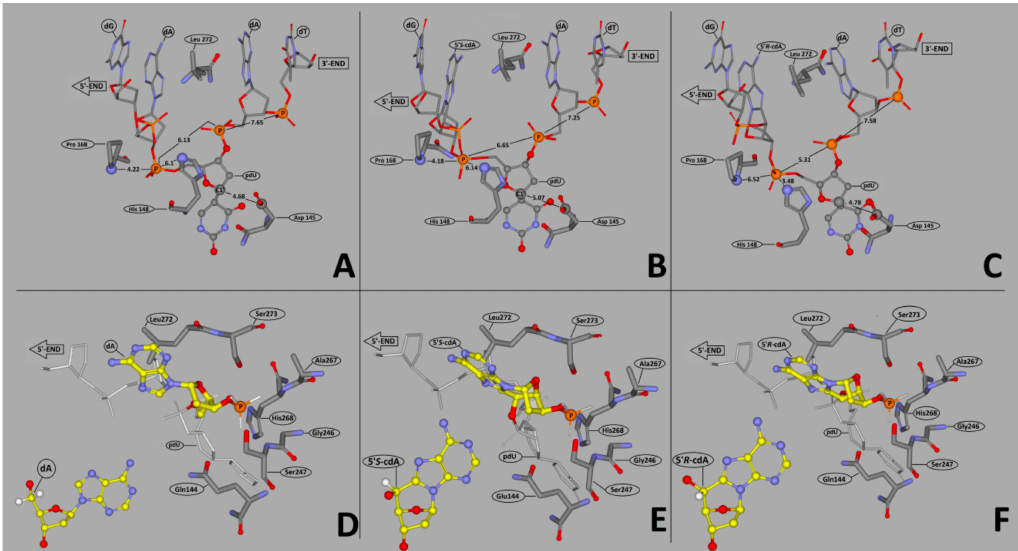
Figure 6. Graphical representation of the distances in Å between the diagnostic amino acids His148 / Pro168 and the phosphate group (5 (cid:48) -cdA PO pdU-3 (cid:48) ), as well as pdU C1’ and His148 endocyclic nitrogen atom: ( A ) ds- Cont.pdU, ( B ) ds- ScdA( + 1) and ( C ) ds- RcdA( + 1). ( D ) The reference ds -oligonucleotide contains 2 (cid:48) -deoxyasdenosine ( ds- Cont.pdU), ( E ) the oligonucleotide contains (5 (cid:48) S )-5 (cid:48) ,8-cyclo-2 (cid:48) -deoxyadenosine ( ds- ScdA( − 1)), ( F ) the oligonucleotide contains (5 (cid:48) R )-5 (cid:48) ,8-cyclo-2 (cid:48) -deoxyadenosine ( ds- RcdA( − 1)) fitting into a suitable protein cave, determined by the amino acids Leu272, Ser273, Ser247, Gly246, Ala267, Gln144, His268. Table 2. Sugar ring parameters (amplitude, phase puckering and dihedral angle values) of dA relaxed and extracted from optimized structure ds-DNA digested by UDG. Nucleoside υ 2 * Phase Amplitude Conformation nucleoside